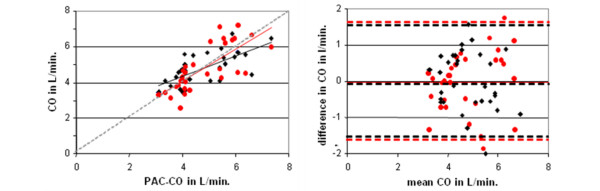
Comparison between NICOM™ and Vigileo™.  (Left panel) Relationship between averaged values of NICOM™ (in red, r = 0.77, not significant (NS) from identity line) and Vigileo™ (in black, r = 0,69, P < 0.05 from identity line) with PAC-CCO during periods of very stable cardiac output (CO). (Right panel) Corresponding Bland and Altman representation: NICOM™ bias = -0.01 L/min with limits of agreements (2 standard deviations) = 1.68 L/min; Vigileo™ bias = -0.01 L/min with limits of agreements (2 standard deviations) = 1.62 L/min.